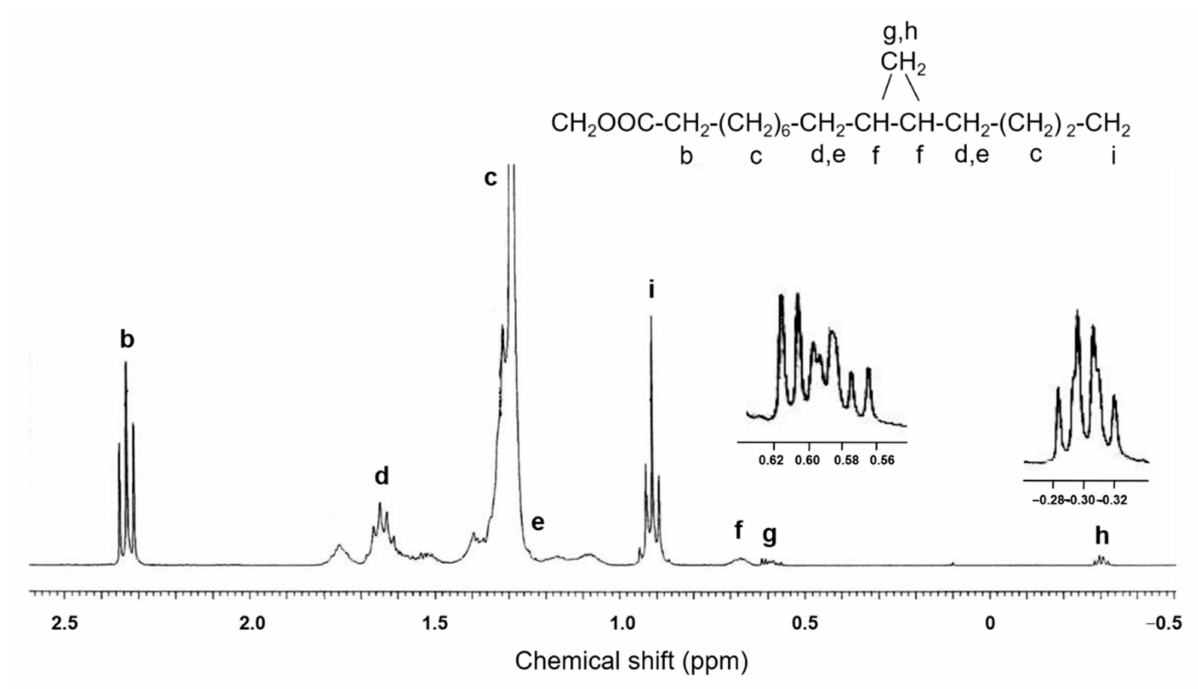
Figure 4. 1 H-NMR spectrum of the saturated fraction from total fatty acids of Solieria pacifica in the region − 0.5 to 2.5 ppm. The peaks around 0.60 ppm and − 0.30 ppm have been